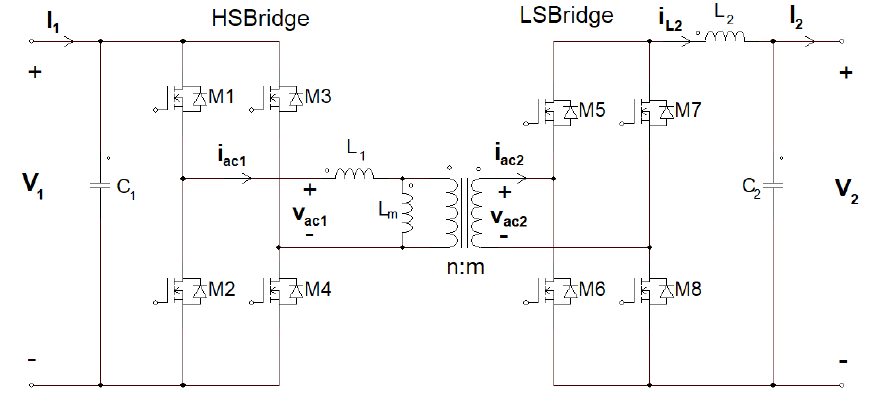
Figure 2. Schematic of the Full Bridge Converter (FBC).